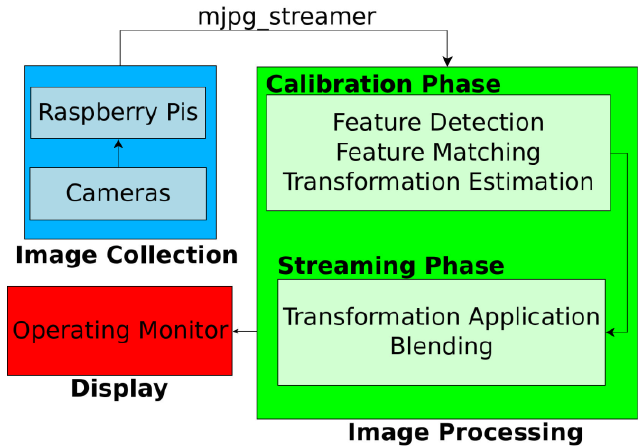
Figure 4. Flowchart of the real-time video stitching process.